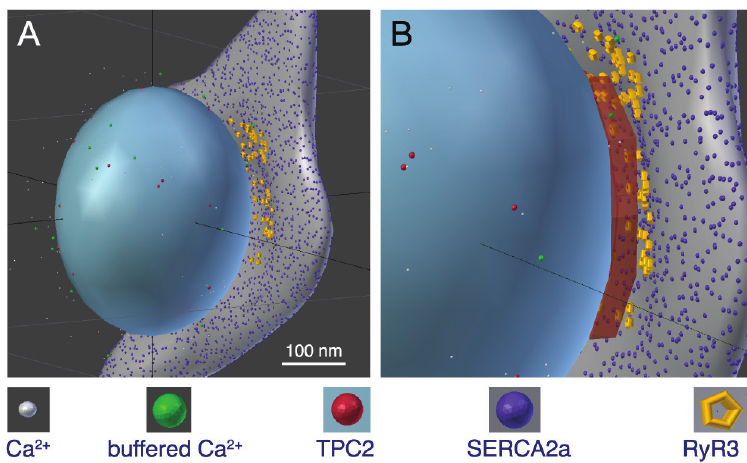
Figure 5. A and B , 3D software reproduction of a lysosome closely apposed to a portion of SR, thereby forming an ≈ 20-nm-wide L-SR nanojunction; this rendering was inspired by a series of observations from micrographs as in Figure 2 (grey object: SR, blue object: lysosome). Included are relevant molecules traversing Brownian motion trajectories produced by the model simulations (see symbol legend below the panels). B , enlarged view of the L-SR junctional region, in which we have displayed the volume object (rust-coloured box) used to measure the [Ca 2+ ] transients like the ones reported in Figure 7. Scale bar: 100 nm. The model geometry and code files are available from the NJ corresponding